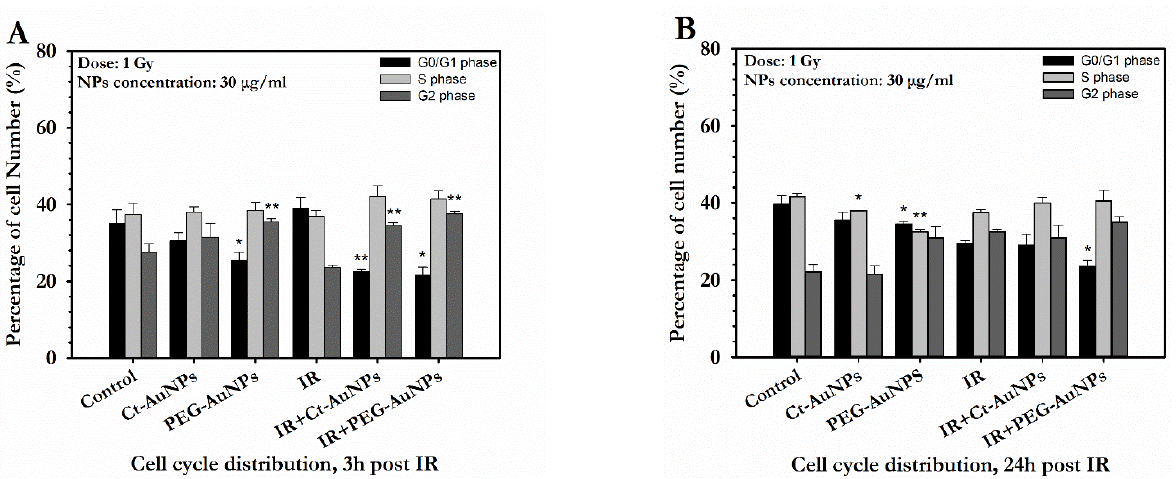
Figure 12. Flow cytometry analysis of cell cycle phase distribution of PC3 cells in dependence of the irradiation and AuNP treatment (30 μ g/mL). ( A ) Cell cycle distribution 3 h after 1 Gy of IR exposure. Cells were treated with AuNPs for 24 h, irradiated and collected 3 h after exposure. ( B ) Cell cycle distribution 24 h after 1 Gy of IR exposure. Cells were treated with AuNPs for 24 h, irradiated and collected 24 h after exposure. Statistical significance was determined using Student t test: * p ≤ 0.05, ** p ≤ 0.01. Non-irradiated groups with AuNPs were compared with the control group to evaluate statistical significance whereas irradiated groups with AuNPs were compared with the radiation alone group.